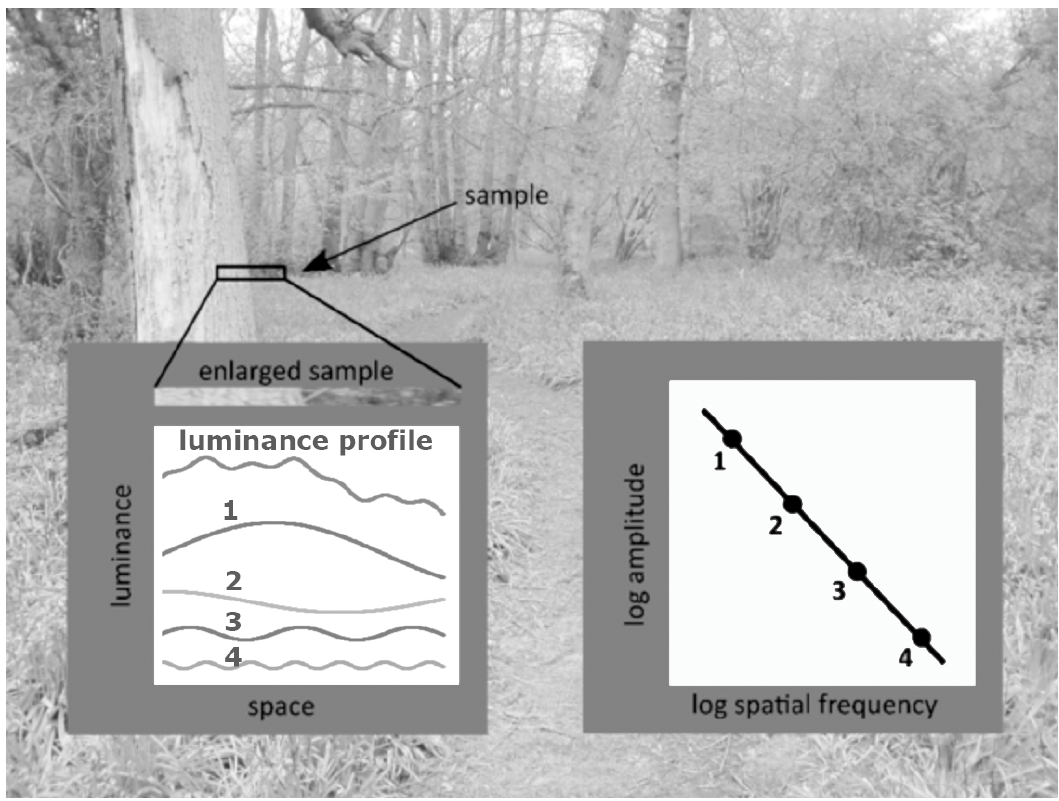
Figure 5. Illustration of the component waves in Fourier analysis. The variation in luminance over space (luminance profile) of the sample shown at the top and enlarged in the first row of the left hand inset can be thought as composed of the addition of the waves shown below and numbered 1–4. The amplitude decreases with their spatial frequency as shown in the right-hand inset.